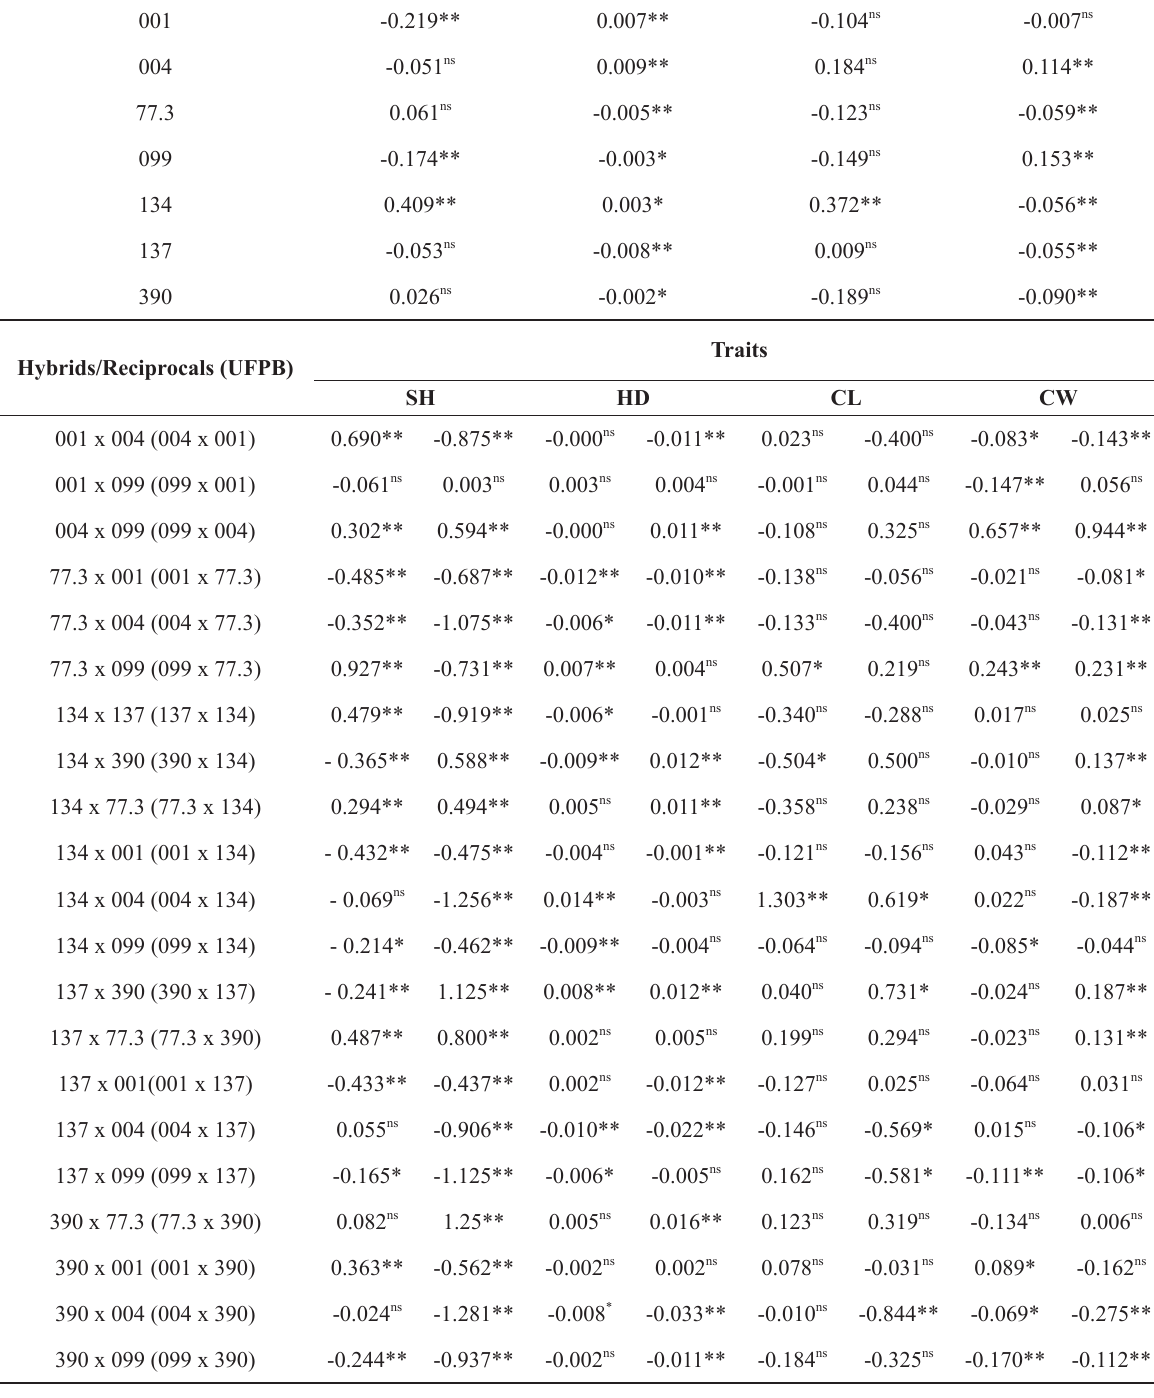
) effects for four seedling and plant traits of ij Capsicum annuum